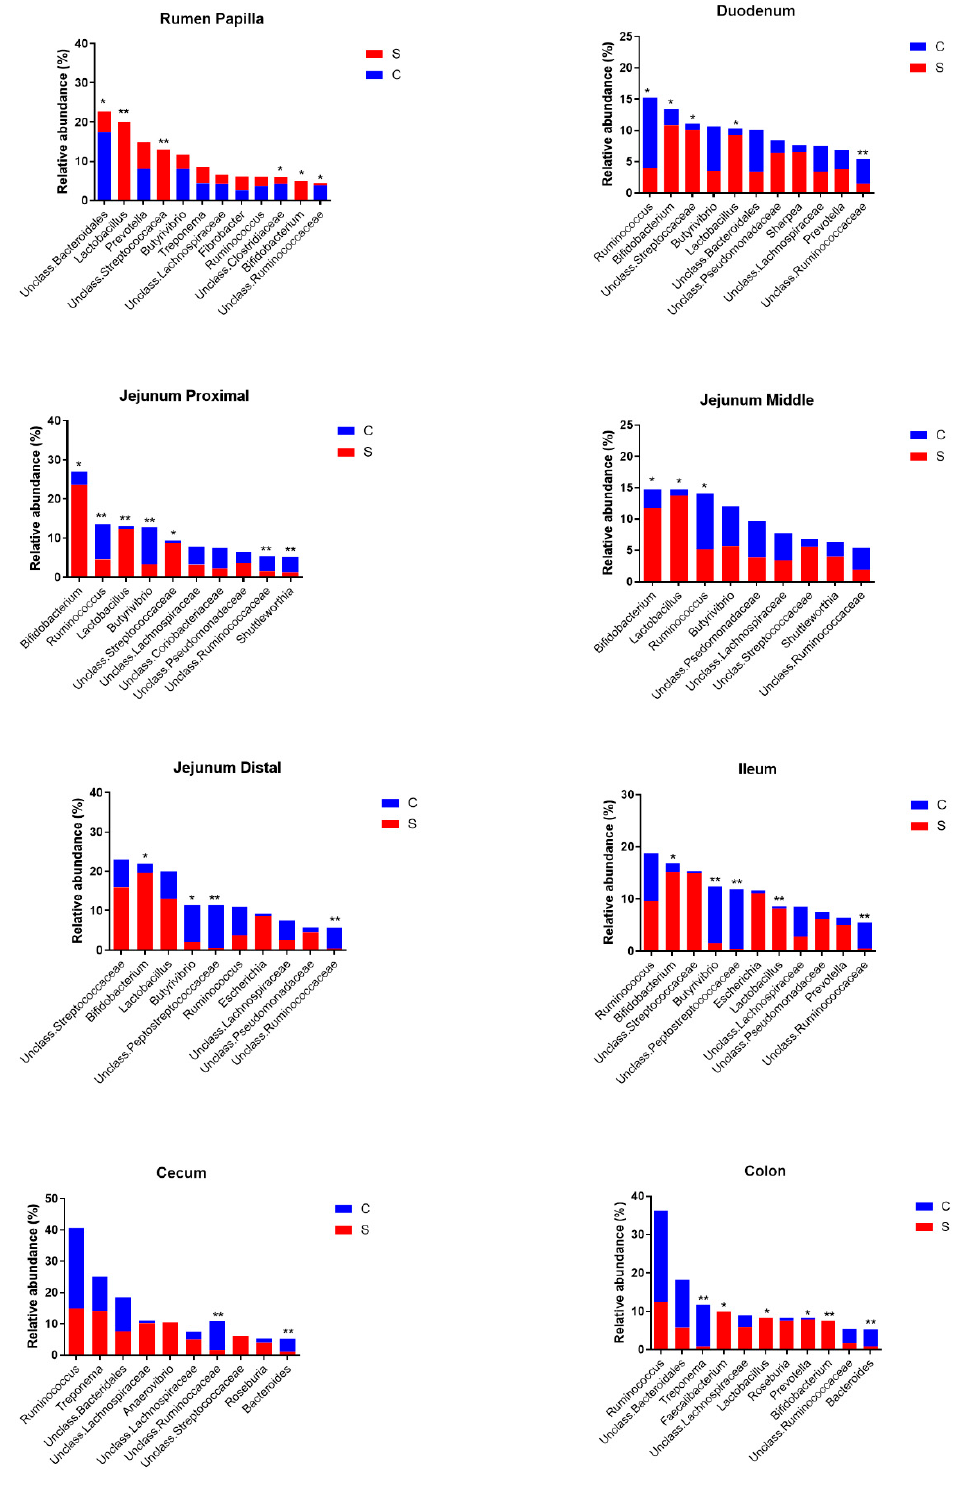
Figure 4. Effects of treatment (C = control, S = SARA) on the most abundant genera by site in the digestive tract. * Relative abundances of genera differ significantly ( p < 0.05) among treatments, ** Relative abundances of genera differ significantly ( p < 0.01) among treatments.